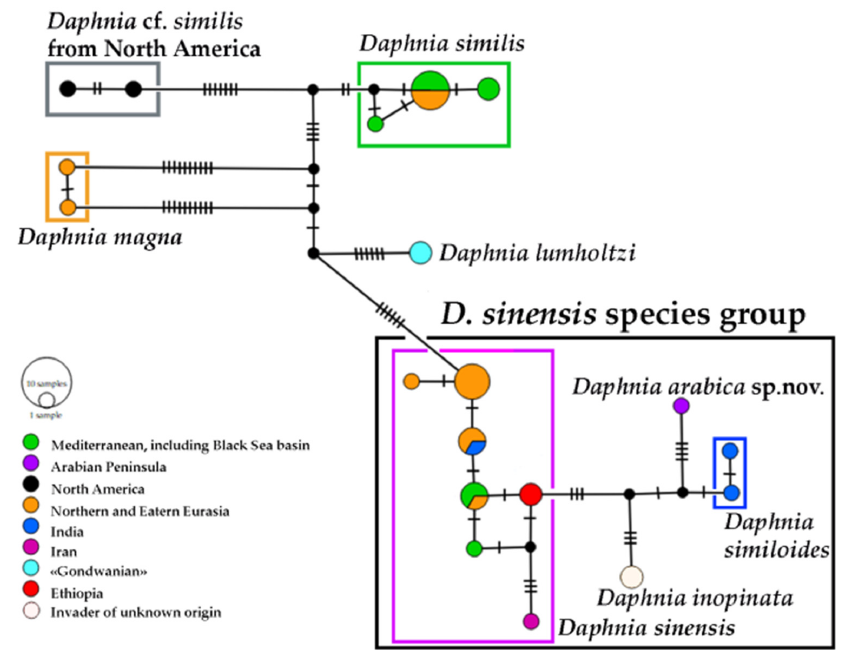
Figure 13. A median-joining networks of studied taxa based on short 12S fragments.